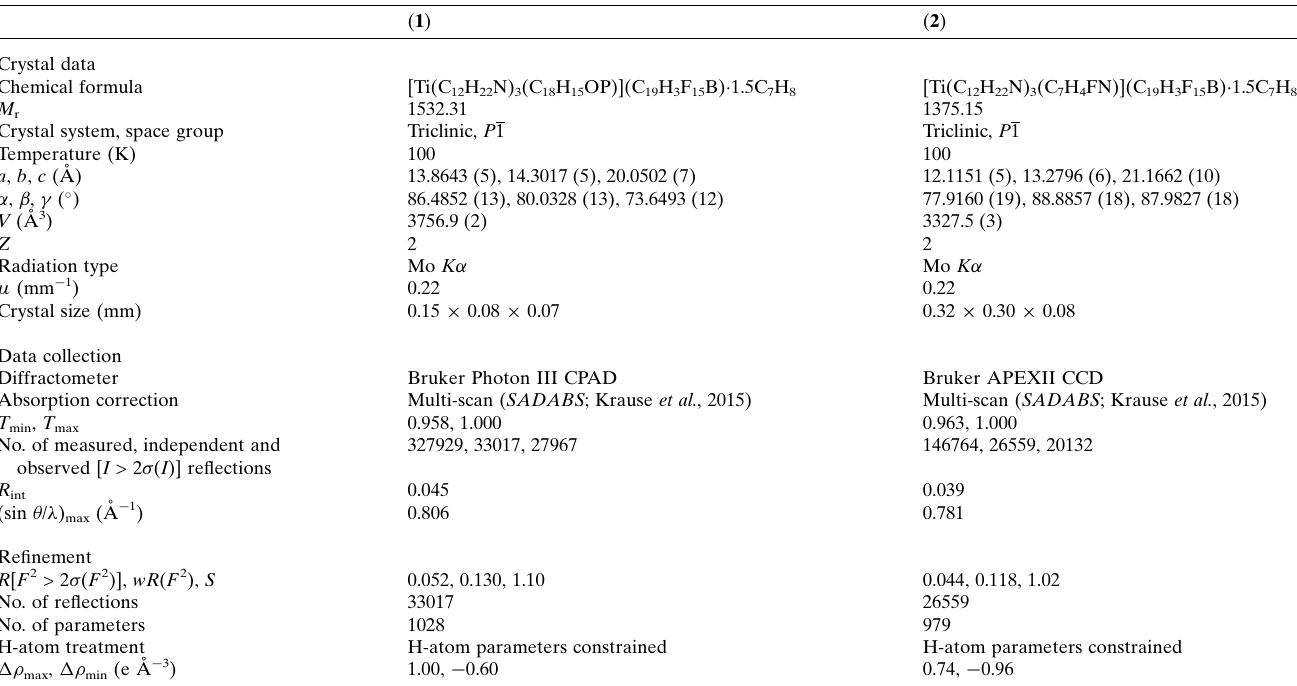
Table 3 Experimental details.